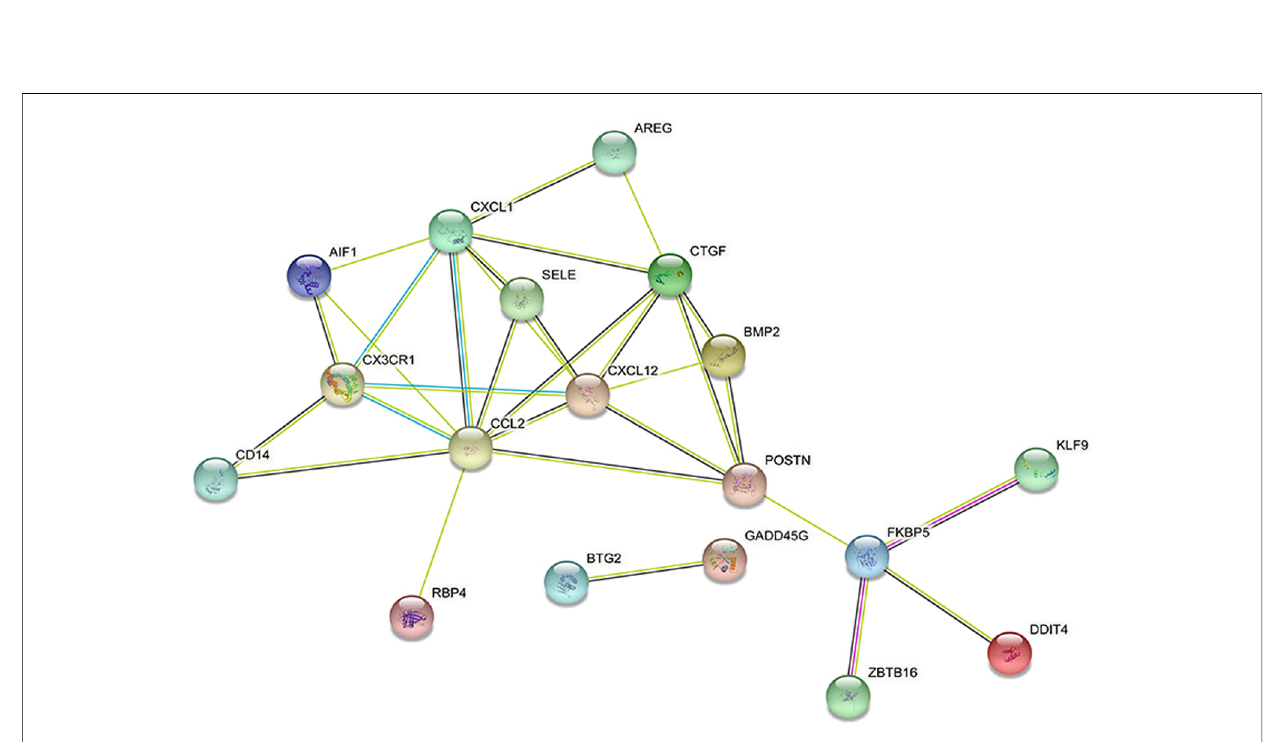
FIGURE 5 Protein – protein interaction network of differentially expressed genes created by